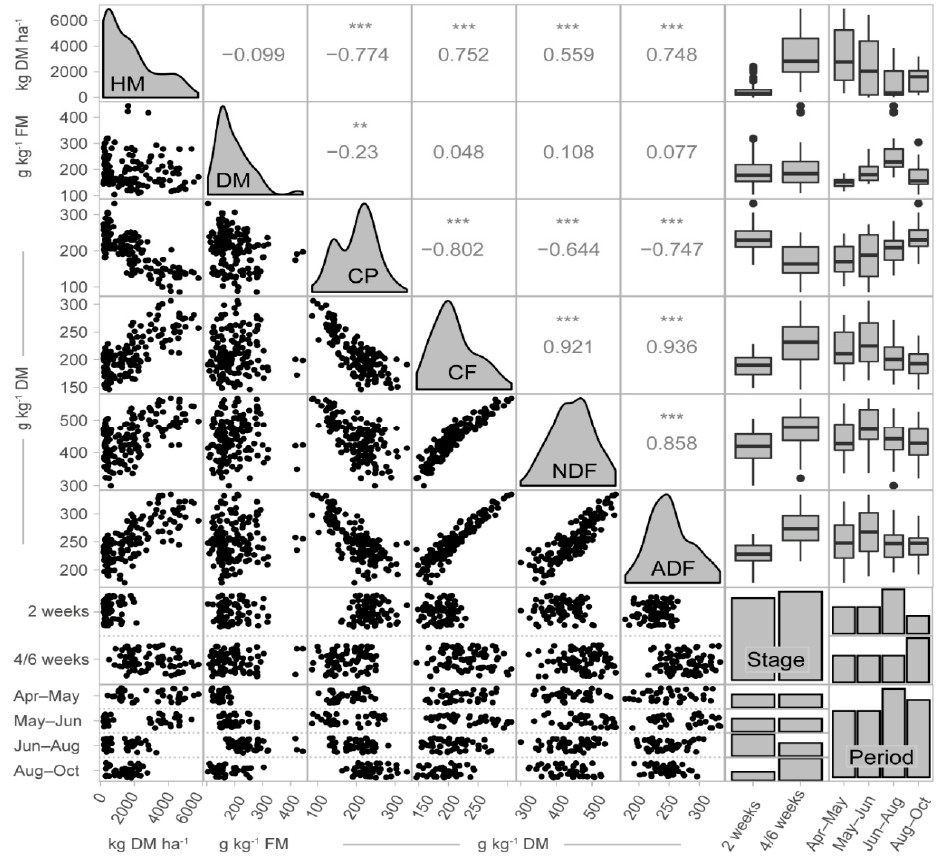
Figure 3. Pairs plot of the reference data (oven-drying and laboratory NIRS, n = 162), the growth stage (two weeks and four to six weeks of growth), and the growth period. The herbage parameters are abbreviated as follows: HM: herbage mass, DM: dry matter, CP: crude protein, CF: crude fiber, NDF: neutral detergent fiber, and ADF: acid detergent fiber. The plots in the diagonal line are density plots that show the distribution of the data. The values of Pearson correlation coefficients and the boxplots are shown above the diagonal. Significance codes: *** ≤ 0.001, ** ≤ 0.01, * ≤ 0.05.